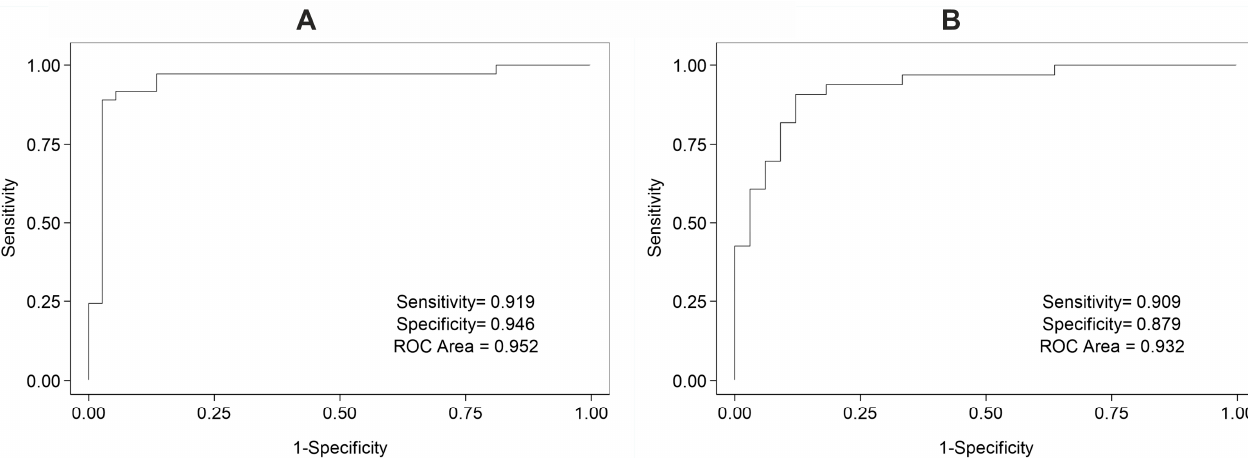
Figure 4. ROC showing accuracy of combined miRNA expression as a biomarker in distinguishing oral ( A ) and laryngeal ( B ) tumor tissue compared with neighboring healthy tissue. ( A ) Combined expression of miR-6510-3p and miR-34c-5p as a biomarker distinguishing oral tumor tissue from nearby healthy tissue with a threshold of − 0.194 determined by the best model: logit(tumor) = − 2.239 − 1.127(miR-6510-3p) + 1.392(miR-34c-5p). ( B ) Combined expression of miR-449a-5p, miR-6510-3p, and miR-149-5p as a biomarker in distinguishing laryngeal tumor tissue from nearby healthy tissue with a threshold of − 0.212 determined by the best model: logit(tumor) = − 1.855 + 0.438(miR-449a-5p) − 1.246(miR-6510-3p) + 1.473(miR-149-5p). In both models, if logit(tumor) score is greater than its corresponding threshold, the diagnosis is positive, otherwise the diagnosis is negative.